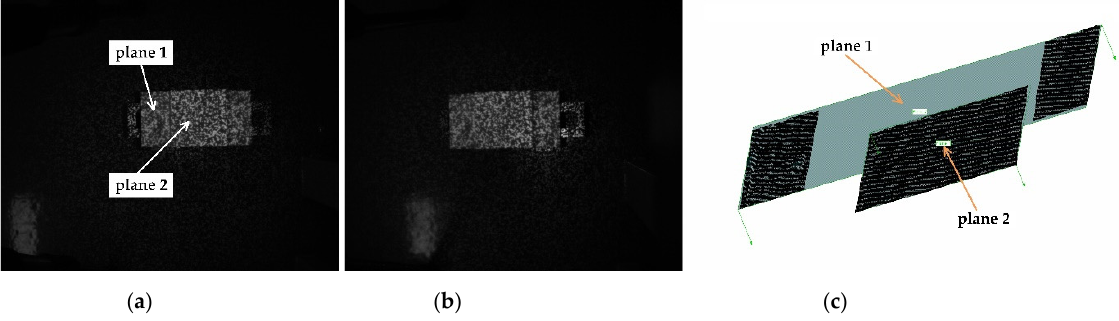
Figure 8. Measurement of a ceramic step block: ( a ) left image; ( b ) right image; ( c ) reconstructed point cloud. Table 1. Statistics for depth measurement error of the ceramic step block.